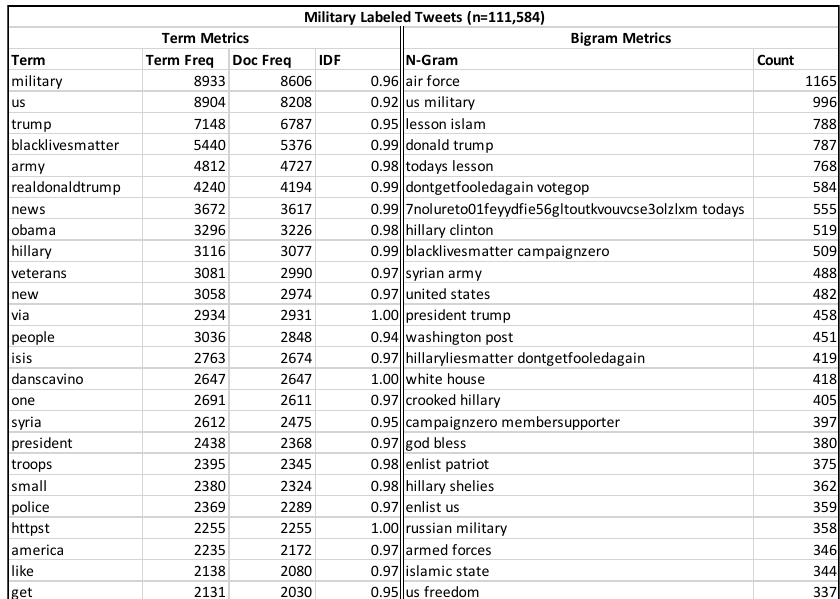
Figure 9. Term analysis from Twitter Russian Influence Operation. The “7nOLureTo01fEYYDfIE56glTOUtkVOuVcse3olzlxM” term is used in a series of